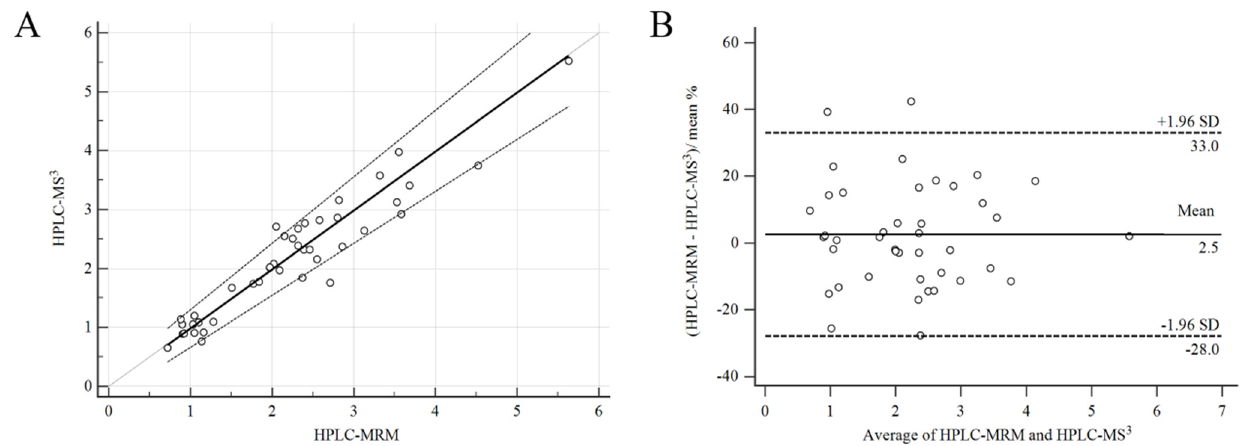
Figure 5. Comparison of voriconazole concentration in patient samples using HPLC-MRM and HPLC-MS 3 . ( A ) The solid black lines are the Passing–Bablok regression. ( B ) Bland–Altman analysis verifies the difference of voriconazole concentration measured using HPLC-MS 2 and HPLC-MS 3 in 42 human plasma samples.